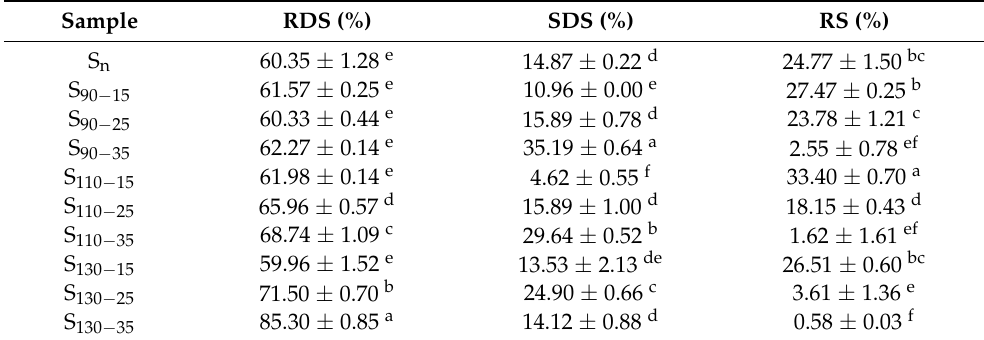
Different letters in the same column indicate significant differences ( p < 0.05). S n indicates native HB flour; S 90 − 15 ,